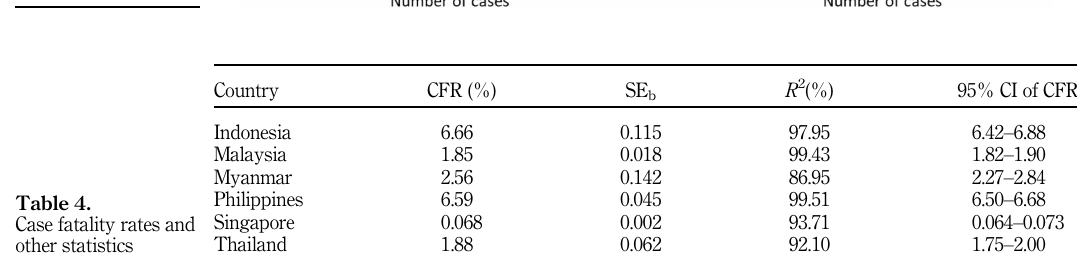
Figure 2. Scatterplots and regression lines of COVID-19 confirmed cases of infections and deaths of the six